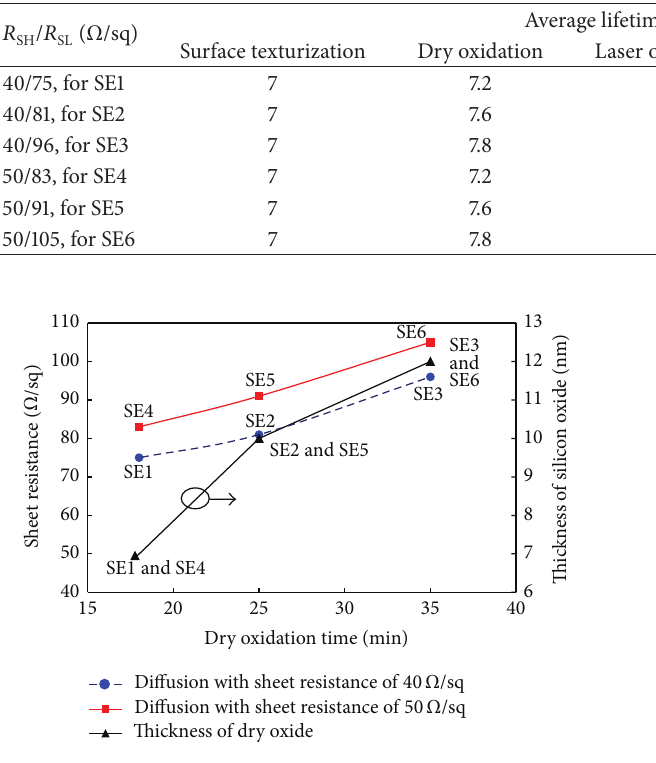
is heavily doped sheet resistance, and 𝑅 SH